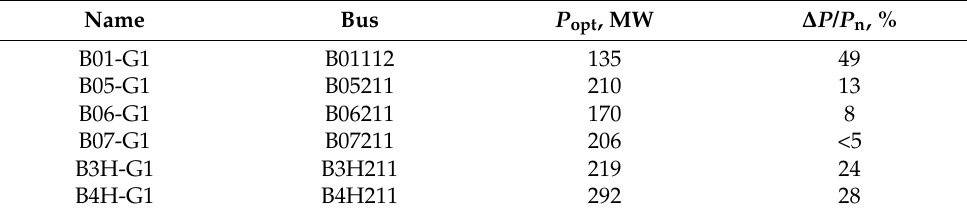
Figure 6. The process of determining the maximum SPA for case 1; ( a ) changing the generation distribution to determine the maximum (global) SPA; ( b ) a graph of changes in the value of the objective function (maximum SPA); ( c ) changing the generation distribution to determine a maximum safe SPA; ( d ) graph of changes in the value of the objective function with the penalty function (maximum safe SPA). Table 3. List of sources with optimal capacity and expected values of power surges calculated for each generator.